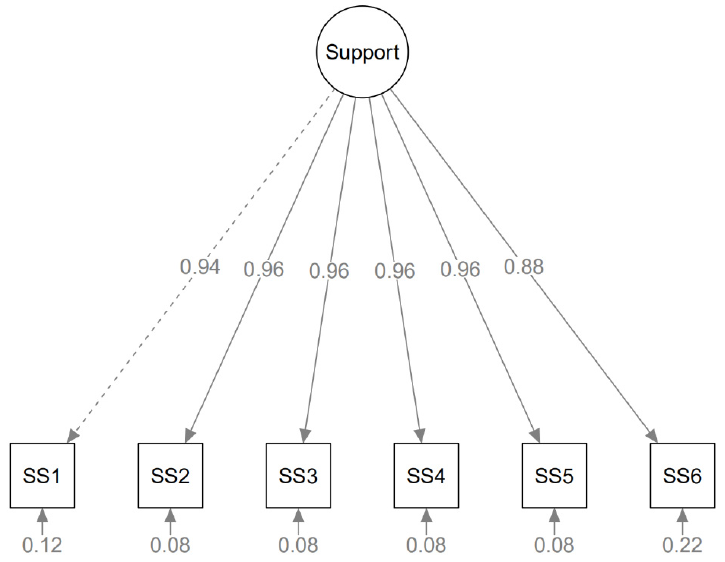
Figure 1. Path diagram of the DCSQ Support scale CFA model.